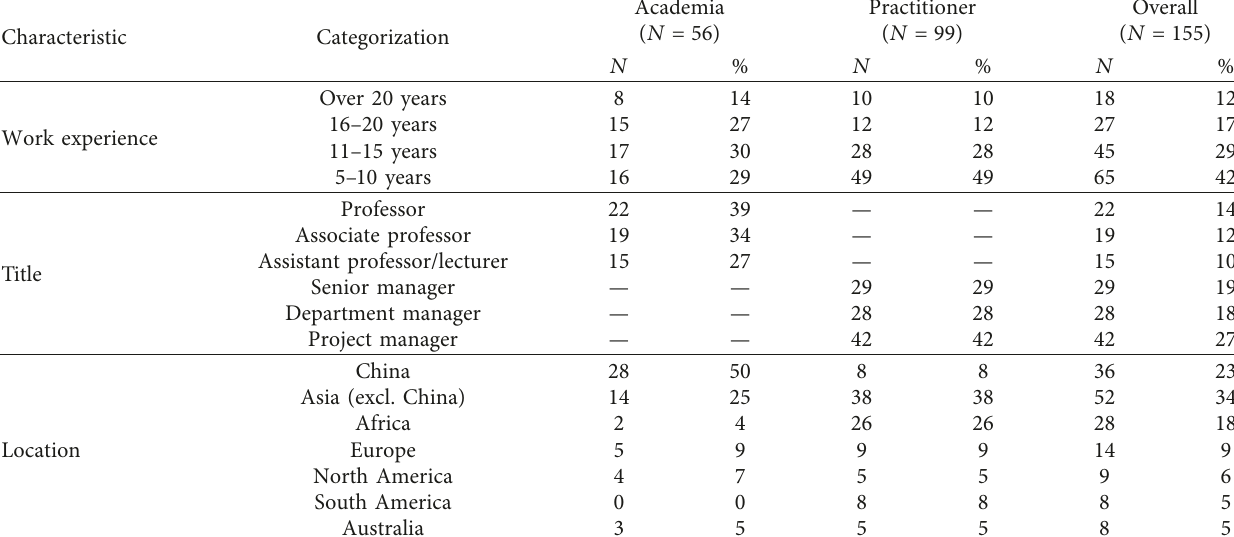
Table 2: Profile of the